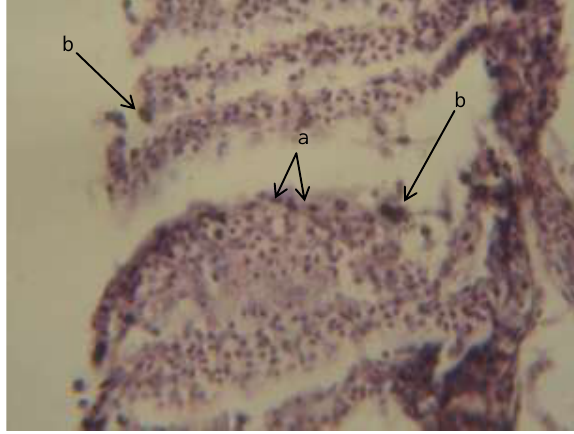
Figure 13: Histological section of gill Cyprinus carpio infected with Branchiomyces spp. , revealing, Branchiomycosis-induced necrosis of the gill filament with (a) residues of congestion and (b) some remains of fungal sporonts. H & E 400